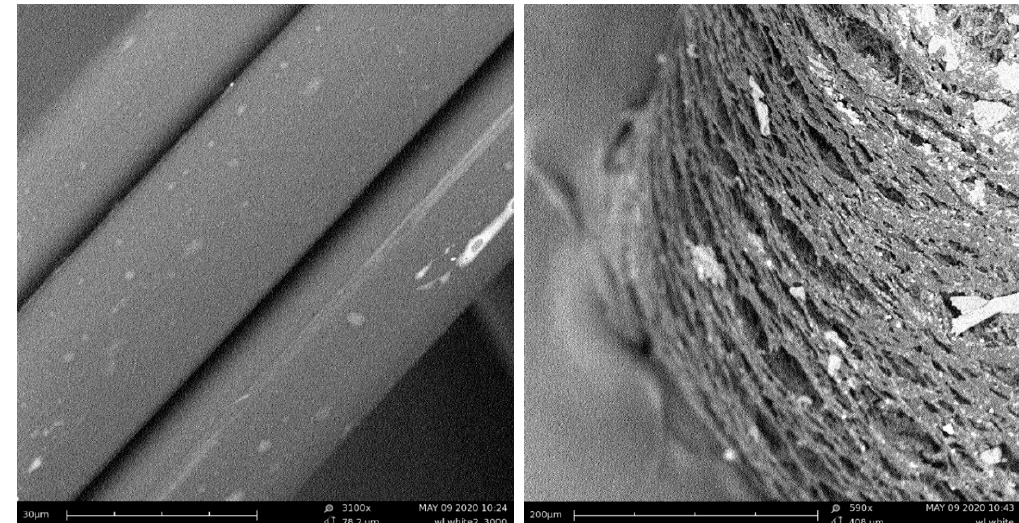
Figure 9. Scanning electron microscope (SEM) images of PPW.